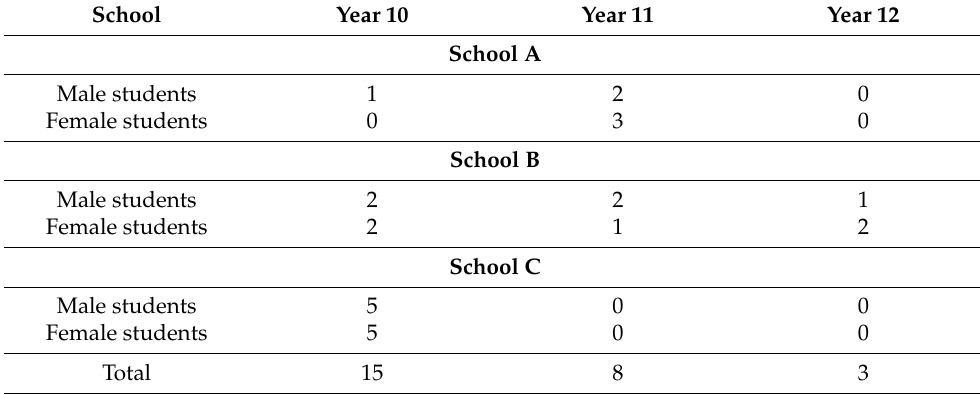
Table 3. Year level distribution by school.